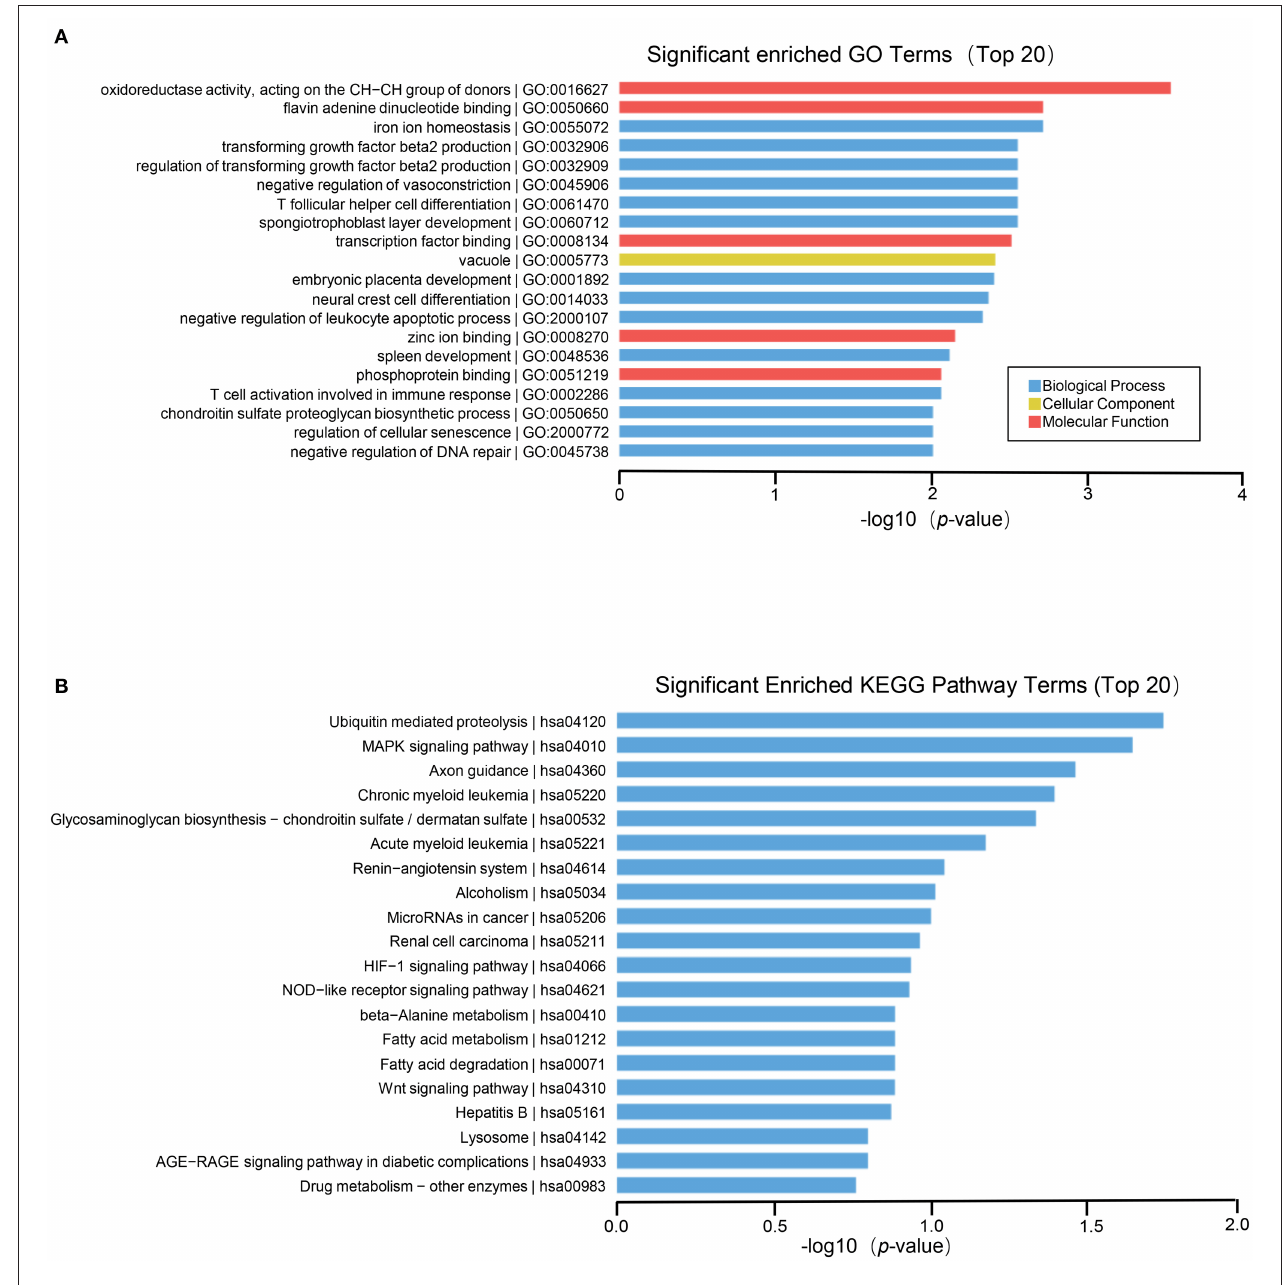
FIGURE 3 | GO and KEGG pathway analysis on the results of circRNAs. (A) Gene ontology analysis. Top 20 GO terms for the difference in circRNA between HT group and non-HT group. (B) KEGG pathway analysis. Top 20 pathways for the difference in circRNA between HT group and non-HT group.